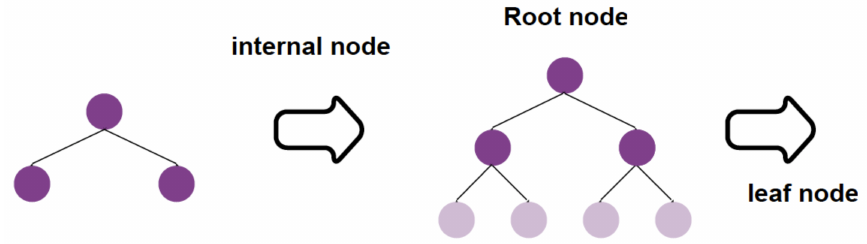
Figure 4. XGboost level-wise tree growth